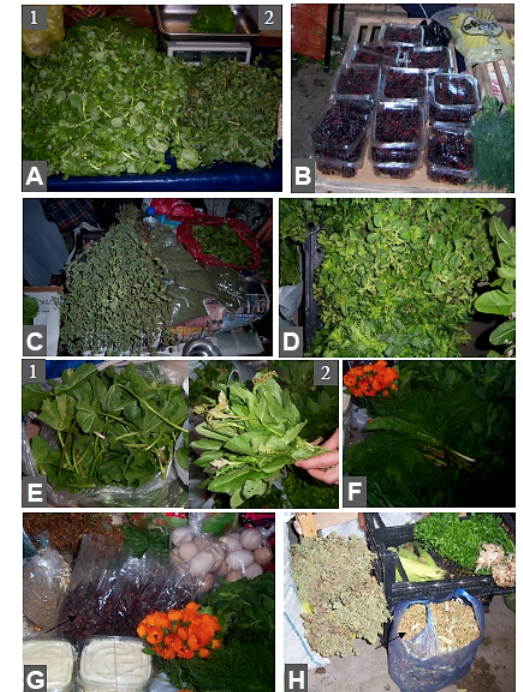
Figure 9 Food plants sold at the bazaar. ( A ) Portulaca oleracea cultivated (1) and wild (2); ( B ) Rubus sp.; ( C ) Origanum sp.; ( D ) Urtica sp. and Mentha sp.; ( E ) Malva sylvestris (1) and Rumex sp. (2); ( F ) Anethum graveolens ; ( G ) Rosa canina ; ( H ) Tilia tomentosa